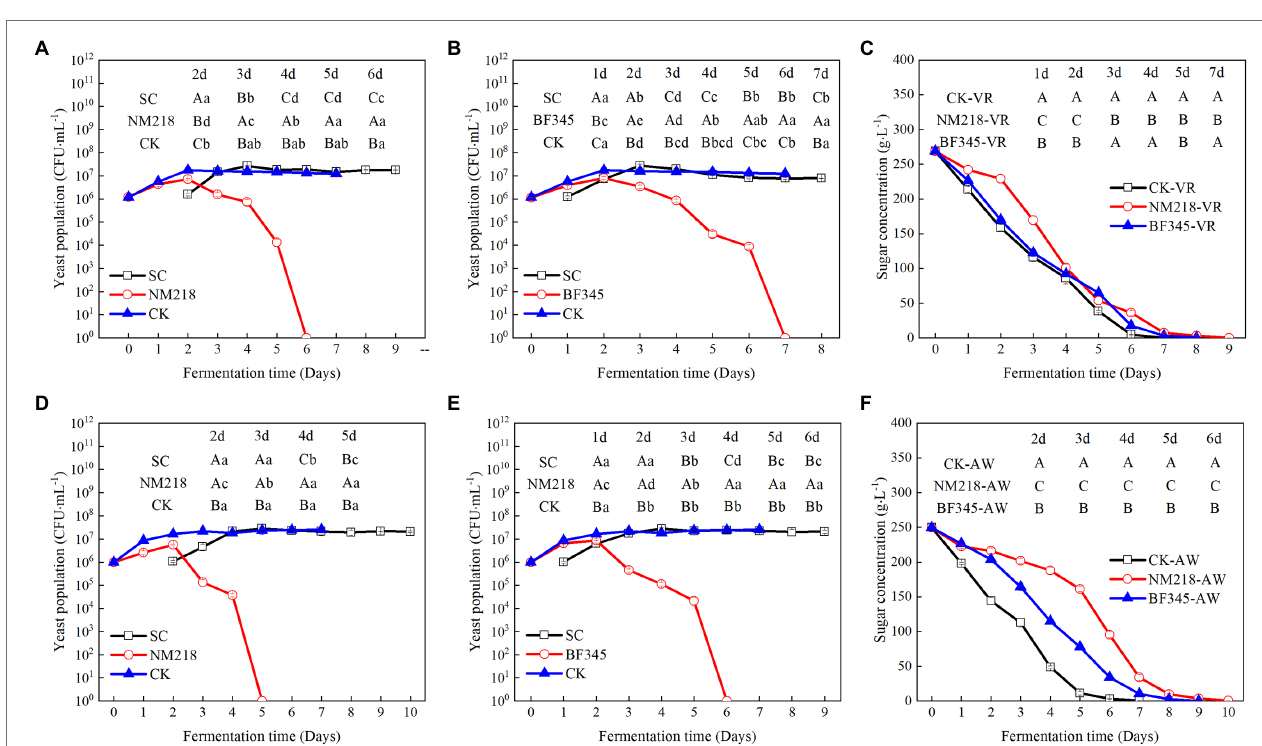
FIGURE 2 | Yeast population dynamics, β -glucosidase activity, and sugar concentration during sequential fermentations in synthetic must. (A) M. guilliermondii NM218 and S. cerevisiae (VR) inoculated sequentially at 48 h intervals. (B) H. uvarum BF345 and S. cerevisiae (VR) sequentially inoculated at 24 h intervals. (C) indicates the sugar content. SC represents strains S. cerevisiae . NM218 and BF345 represent strains M. guilliermondii NM218 and H. uvarum BF345, respectively. The blue line indicates the β -glucosidase activity (EA).